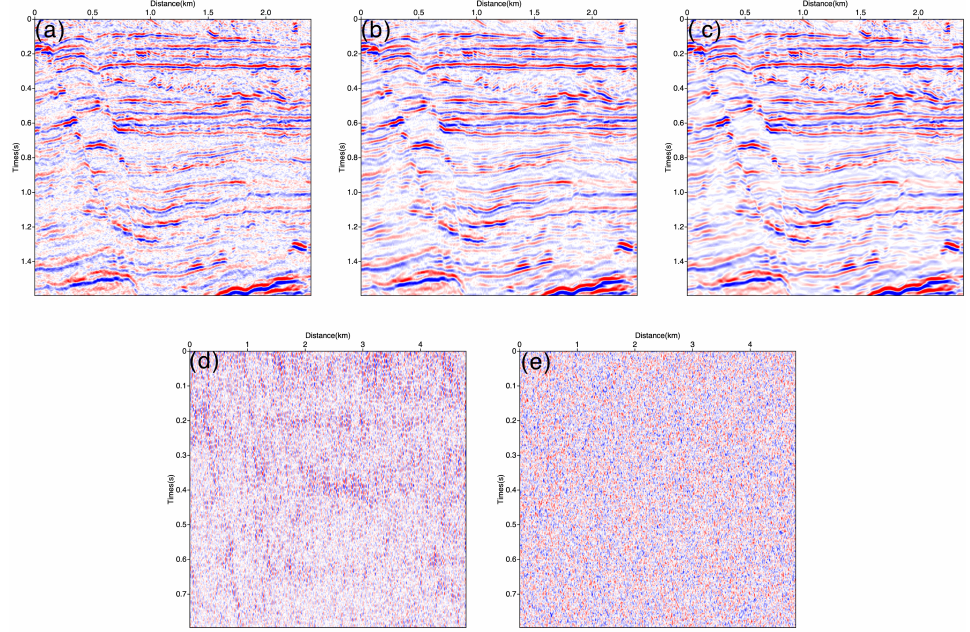
Figure 10. The comparison of the denoised results in real seismic data. ( a ) The contaminated real seismic data. ( b , d ) Denoised result and removed noise using U-Net without the noise level map. ( c , e ) Denoised result and removed noise using attention-CNN with the noise level